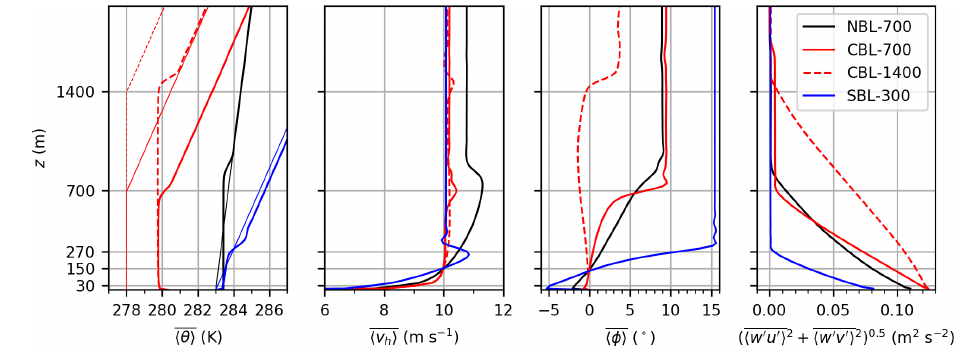
Figure 3. Vertical profiles of potential temperature ( θ ), horizontal wind speed ( v h ), wind direction ( φ , clockwise positive) and total (resolved + subgrid-scale) kinematic vertical momentum flux. The thin lines are initial profiles. The thick lines represent quantities that are horizontally averaged ( (cid:104)•(cid:105) ) over the entire precursor domain and temporal averaged ( • ) over the last hour of the precursor simulation. (cid:104) θ (cid:105) , (cid:104) v h (cid:105) and (cid:104) φ (cid:105) are used as inflow profiles for the main simulations. BL heights of 700 and 1400m, as well as rotor top ( z = 270m), rotor bottom ( z = 30m) and hub height ( z = 150m), are marked on the vertical axis with horizontal grey